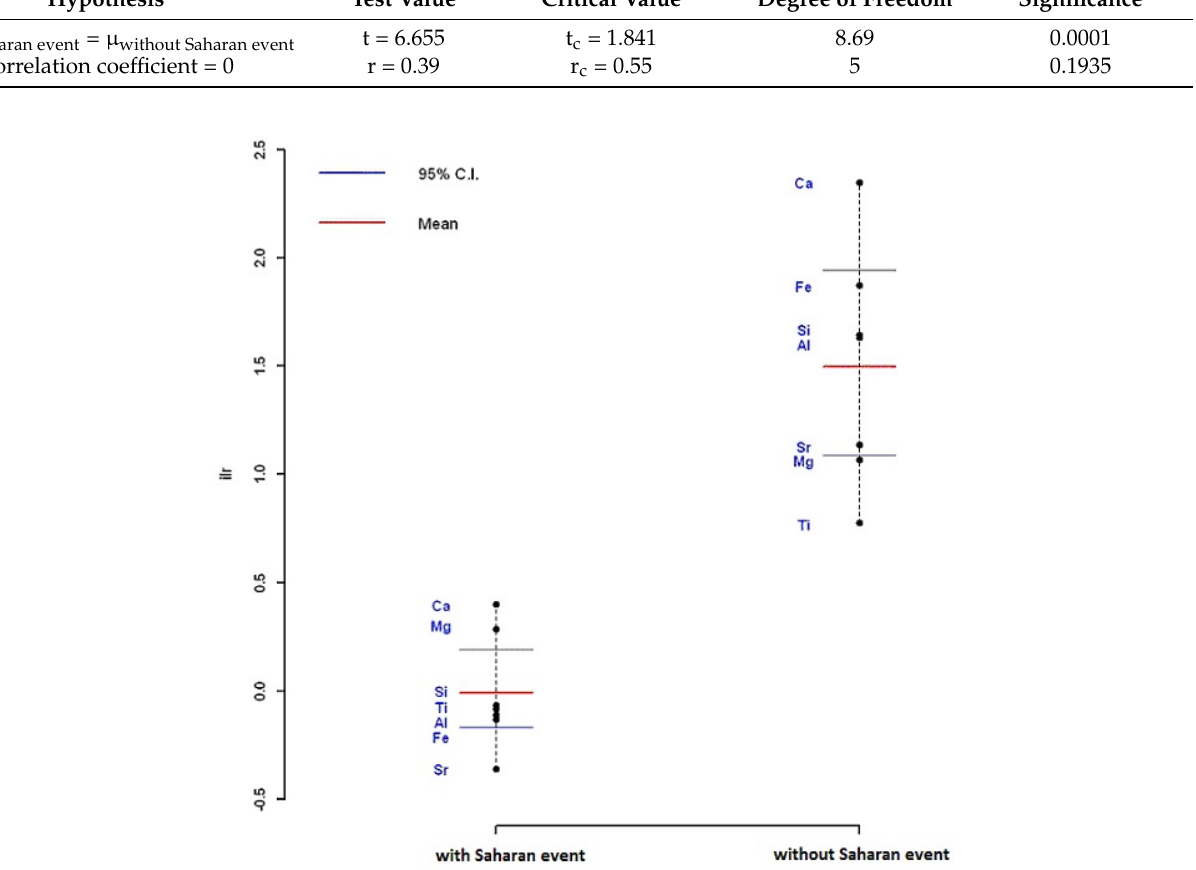
Table 2. t -test about two means and correlation test.